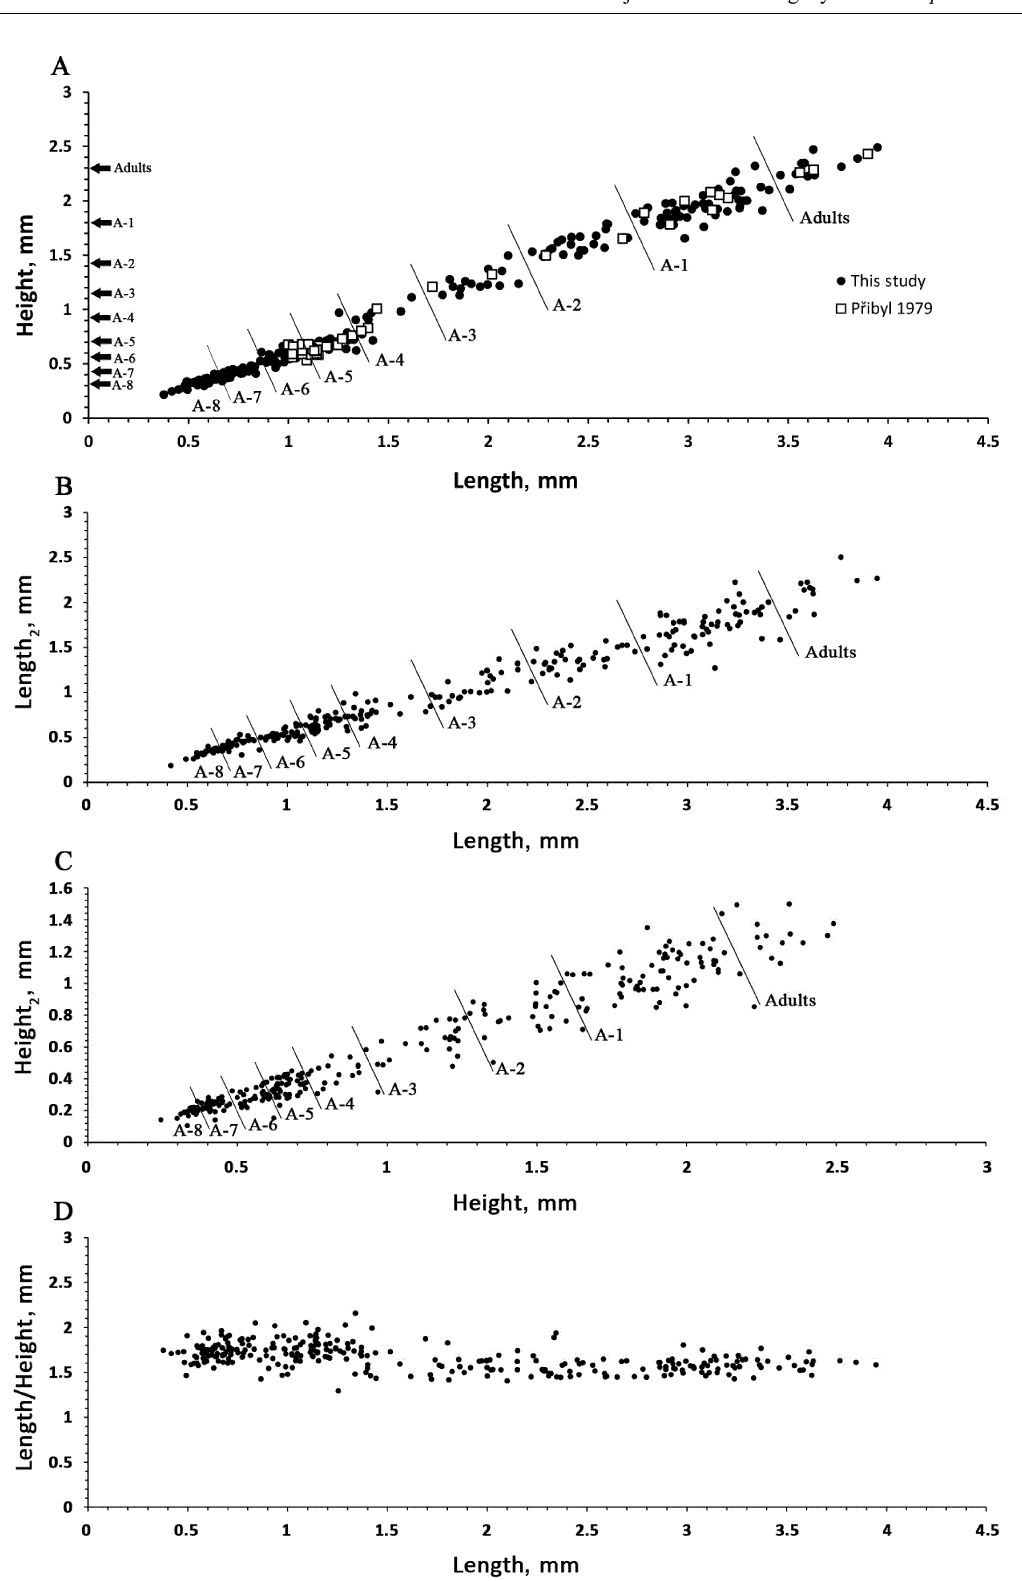
Fig. 2. A (cid:150) D . Scatter plots of Conchoprimitia osekensis showing instars and adults. Instar heights inferred from Brooks(cid:146) rule are marked with arrows on the y -axis (beginning of the mean height of instar A-8, each subsequent arrow being located 1.26 times the previous height). Dividing lines separating instars in A(cid:150)C were calculated based on Brooks(cid:146)